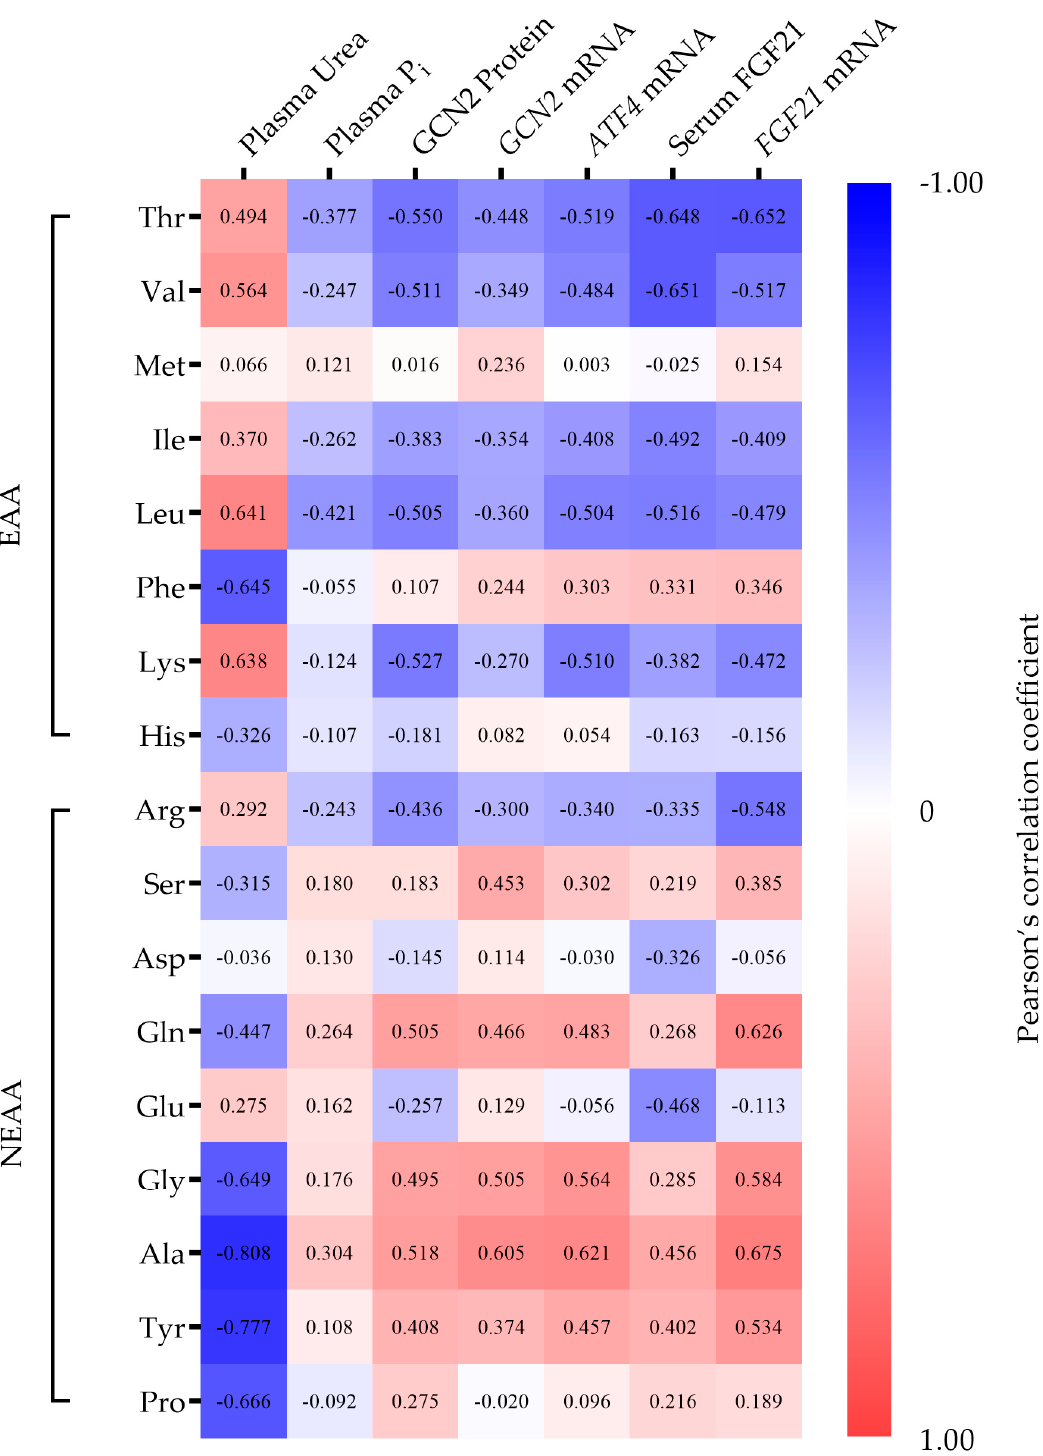
Figure 5. Correlation heatmap of circulating plasma EAA and NEAA and plasma urea, plasma P i , serum FGF21, GCN2 mRNA, ATF4 mRNA, FGF21 mRNA expression, and GCN2 protein expression in young goats fed an N- and/or P-reduced diet. The dataset was formed by combining the control group (n = 7), N-reduced group (n = 7), P-reduced group (n = 7), and N- and P-reduced group (n = 7). The value of the correlation coefficient is indicated by the color range from 1 (strongly positive: deep red) to − 1 (strongly negative: deep blue).